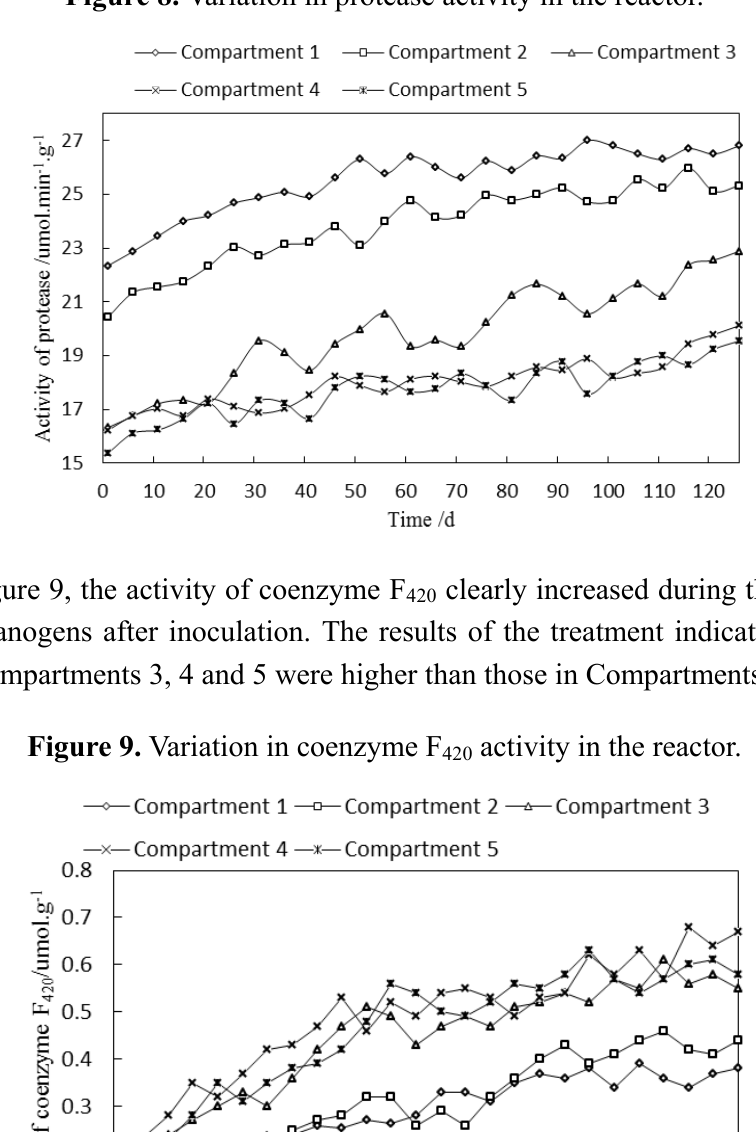
Figure 8. Variation in protease activity in the reactor.